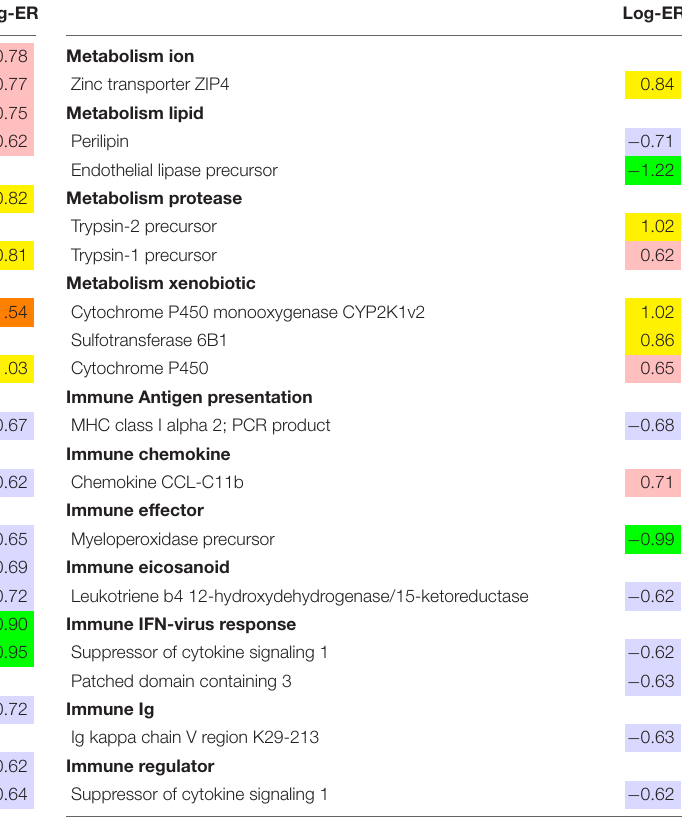
TABLE 9 | Microarray analysis results showing genes with expression change in the liver of salmon fed ScB compared to the FO diet ( n = 12). Cell folding, protein modification Log-ER